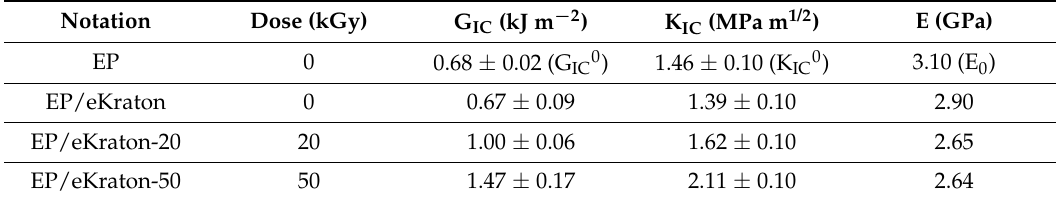
Table 3. Critical strain energy release rate (G IC ), critical stress intensity factor (K IC ), and modulus of elasticity (E) of the neat epoxy (EP) thermoset compared with EP/eKraton blends prepared with different irradiation doses (mean values and standard